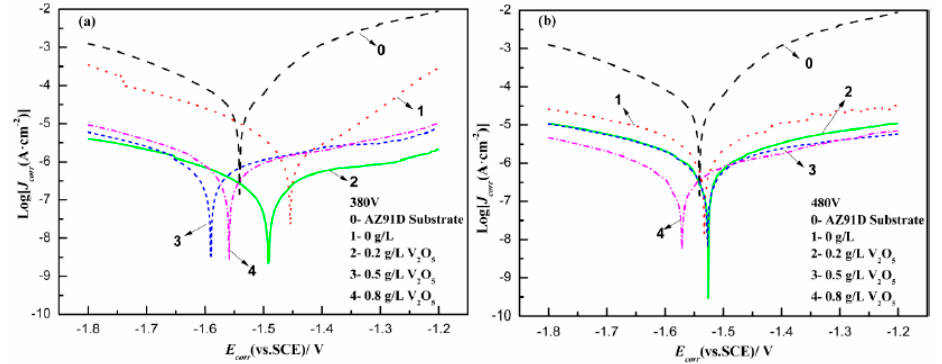
Figure 9. Potentiodynamic polarization (PDP) curves measured on MAO coated samples fabricated under different loading voltages with different V 2 O 5 contents: ( a ) 380 V, ( b ) 480 V. Table 3. Derived results from polarization curves shown in Figure 9.